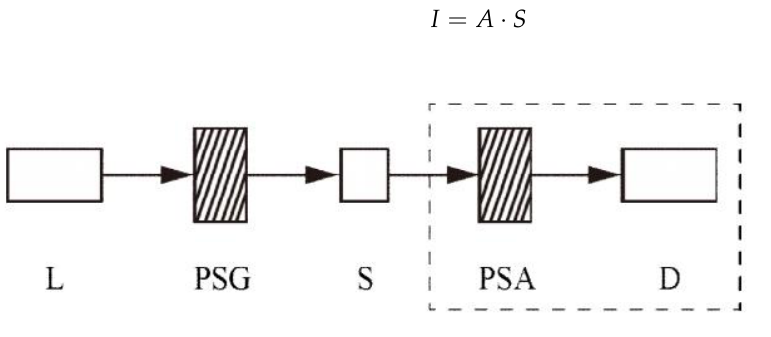
Figure 1. Stokes vector measurement system (in dotted box). L: light source, PSG: polarizer, S: sample; PSA: polarizer, D: light intensity detector.